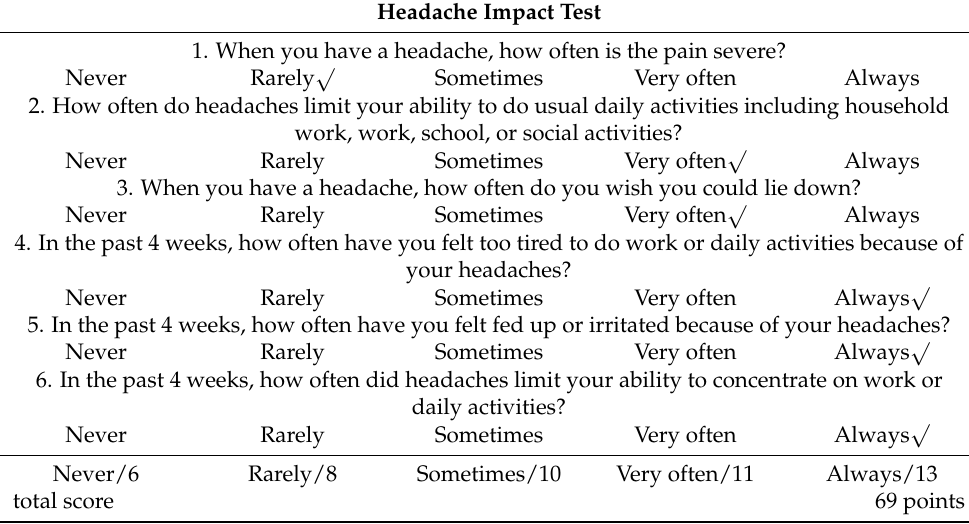
Table 1. Headache impact test of the